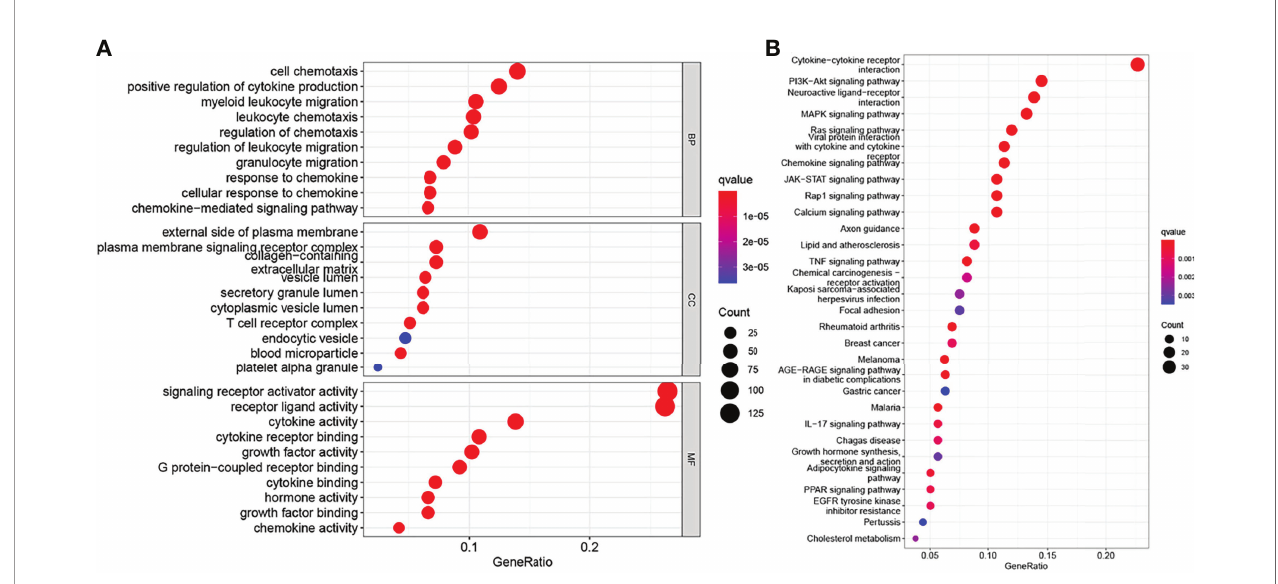
FIGURE 2 | Functional enrichment of genes in the brown module. (A) Gene Ontology (GO) functional enrichment, include biological process (BP), cellular component (CC), and molecular function (MF). (B) Kyoto Encyclopedia of Genes and Genomes (KEGG) pathways enrichment analysis ( P < 0.05).